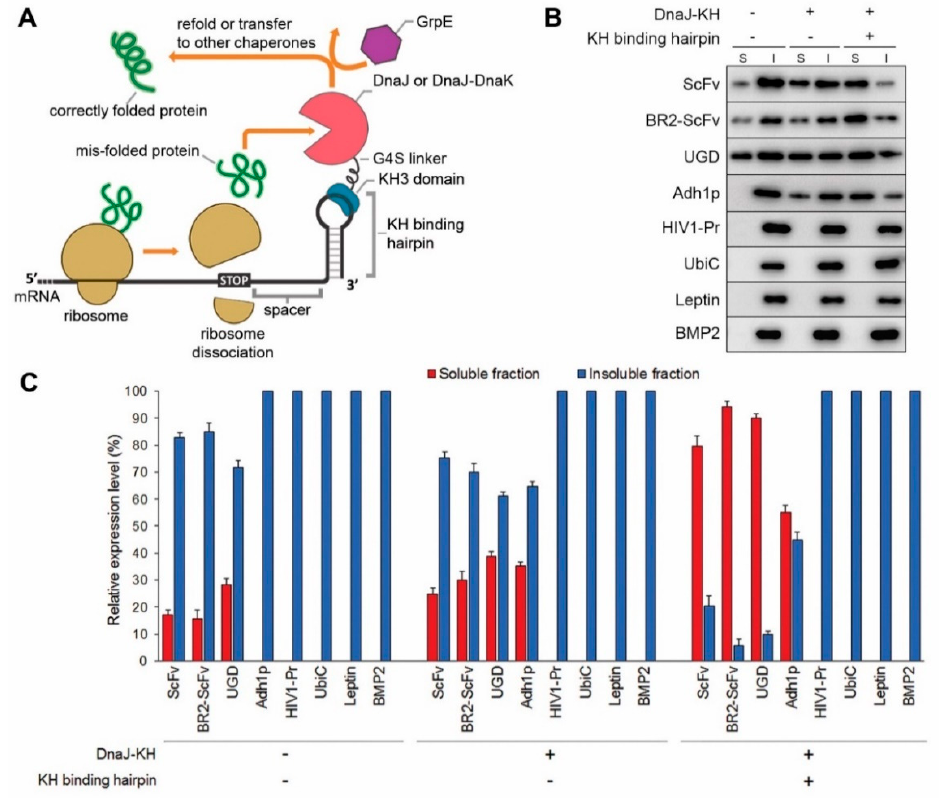
Figure 1. Solubilization of recombinant proteins by the chaperone-recruiting mRNA scaffold (CRAS) system. ( A ) Schematic representation of the CRAS system-mediated in vivo protein refolding process. A molecular chaperone (DnaJ, or DnaJ and DnaK fusion (DnaJK)) fused with the Nova-1 KH3 RNA binding domain was co-expressed with a target recombinant protein containing a KH cognate stem-loop sequence. KH-binding structure introduction into the mRNA 3 ′ UTR allows fusion chaperone protein recruitment to the 3 ′ UTR, facilitating nascent protein binding to prevent aggregation or for transfer to other molecular chaperones for proper folding. In the DnaK chaperone system, DnaJ is the first co-chaperone to bind to the substrate, DnaK is the main foldase responsible for the substrate re-folding, and GrpE as the nucleotide exchange factor releases the substrate from DnaK via an ATP-independent manner. The illustrated GrpE is either expressed from E. coli genome or overexpressed from a plasmid. ( B ) Western Blot analysis showing the soluble (S) and insoluble (I) fractions of recombinant proteins expressed using anti-His-tag antibody. The presence (+) and absence ( − ) of CRAS components, chaperone fusion DnaJ-KH, and the KH binding hairpin on mRNA 3 ′ UTR are indicated. The cropped blots are shown with the black lines surrounding blots indicate the cropping lines. Full-length blots of these cropped images are presented in Supplementary Figure S2. ( C ) Solubilization of 8 selected aggregation-prone recombinant proteins (ScFv, HIV1-Pr, BR2-ScFv, UGD, Adh1p, UbiC, Leptin, and BMP2) upon co-expression with DnaJ-KH, or both DnaJ-KH and the 3 ′ UTR hairpin loop. Soluble protein quantification was conducted using ImageJ v1.48 software (National Institutes of Health) on Coomassie Blue-stained SDS-PAGE images. Error bars indicate ± s. d. from three independent experiments.